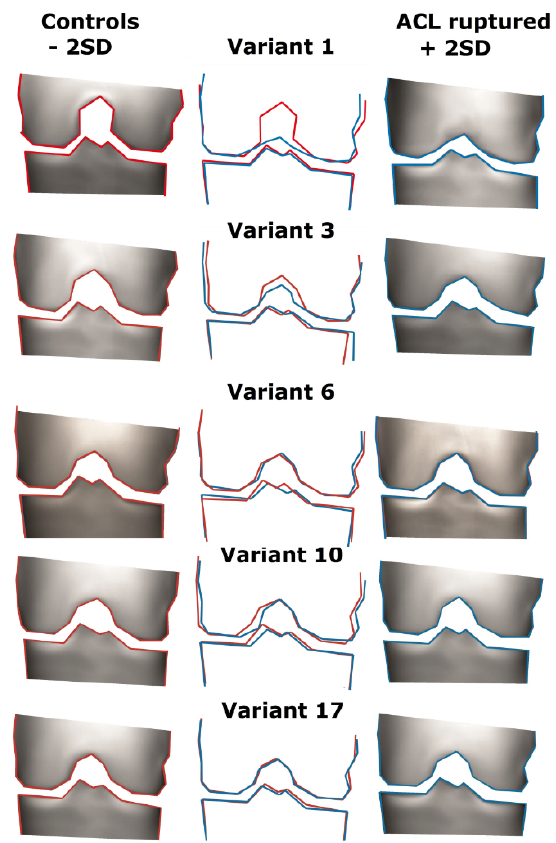
Figure 2. Graphic outcomes of statistic shape modeling: five variants that are significantly differ- ent for patients with intact and ruptured ACL. On the left and right sides are the two extremes (+/ − 2.5 SD); in the middle is the overlay of both sides. SD =